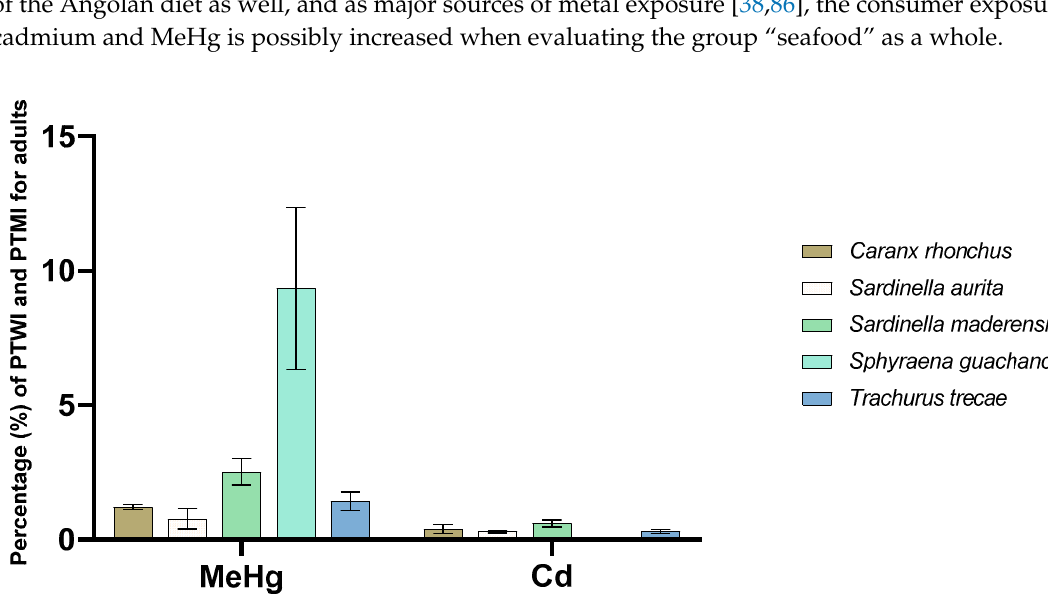
Figure 4. Potential consumer exposure to methylmercury (MeHg) and cadmium (Cd) for adults when a portion of 50 g fish fillet is consumed one time per week and every day for a month for MeHg and Cd, respectively. The potential consumer exposure is compared to the provisional tolerable weekly intake (PTWI) for MeHg and provisional tolerable monthly intake (PTMI) for Cd, as set by the Joint Expert Committee on Food Additives (JECFA).